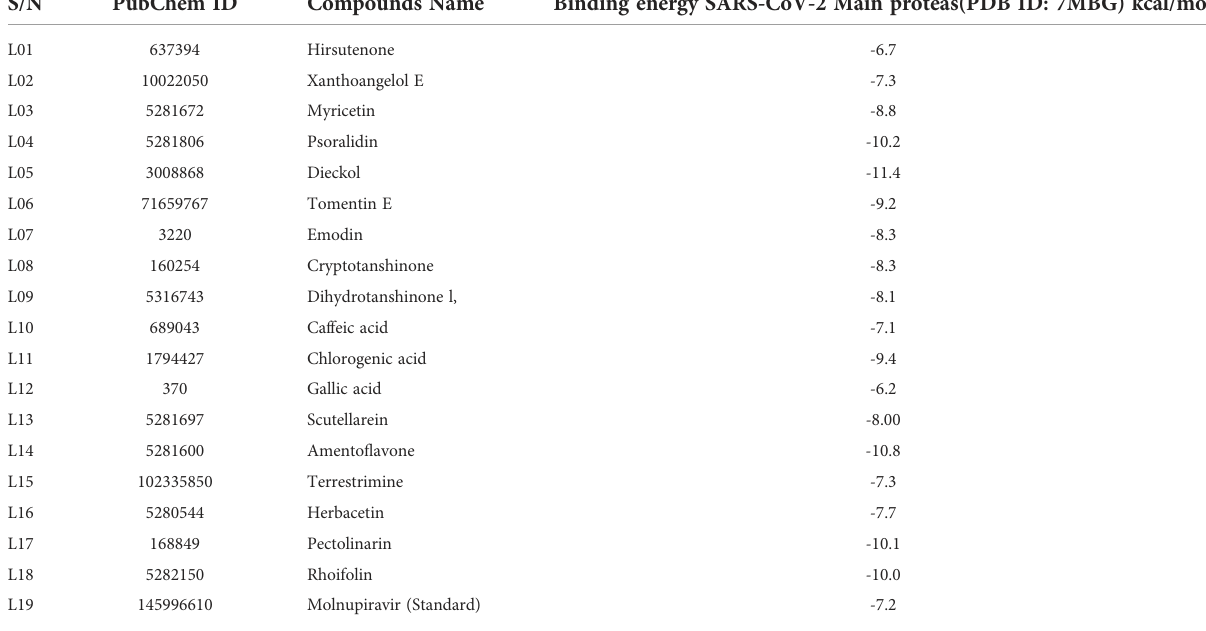
TABLE 3 Binding energy SARS-CoV-2 main